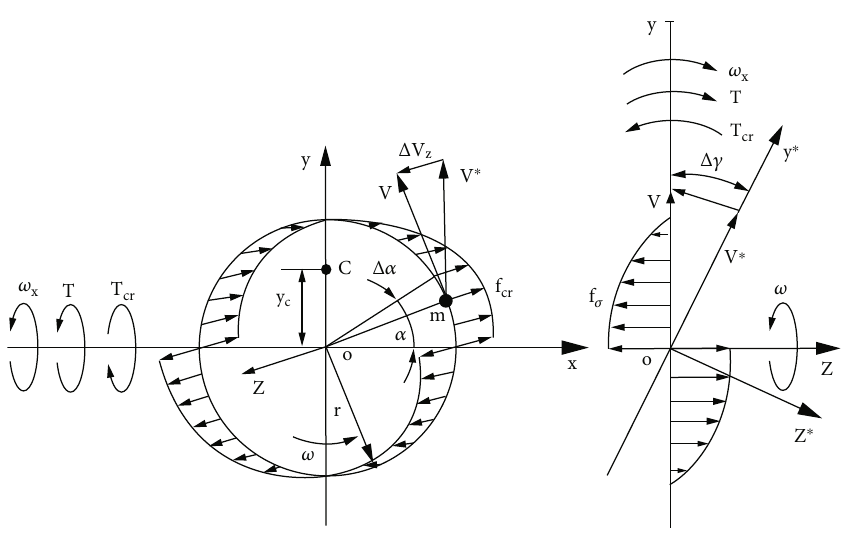
Figure 3: Schematic of the acting forces, torques, and motions of the spinning